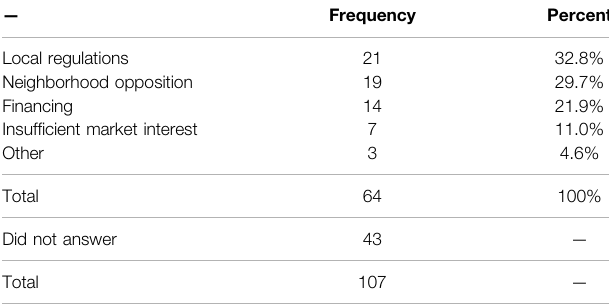
TABLE 11 | Frequency of second most signi fi cant Challenge.